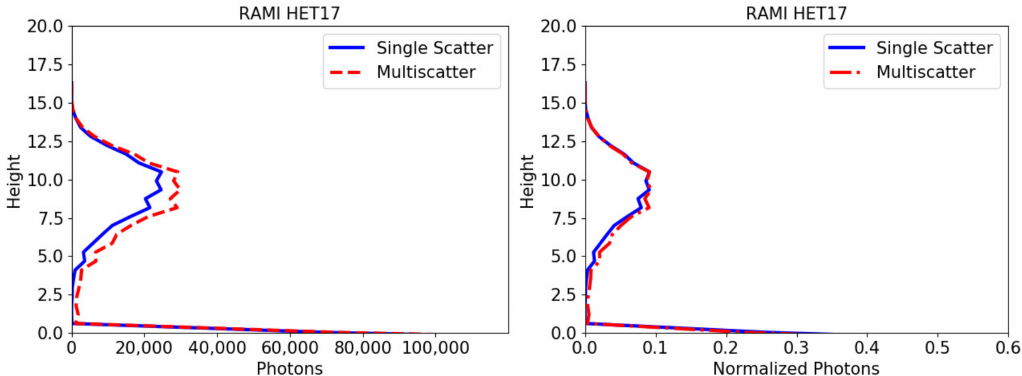
Figure 1. Lidar waveforms created by DIRSIG, approximating the configuration for the RAMI-IV study (both single and multiscatter) for the HET17 scene. The left plot is the waveform in terms of photons, while the right plot waveforms are normalized to have an integral of one, as was performed in